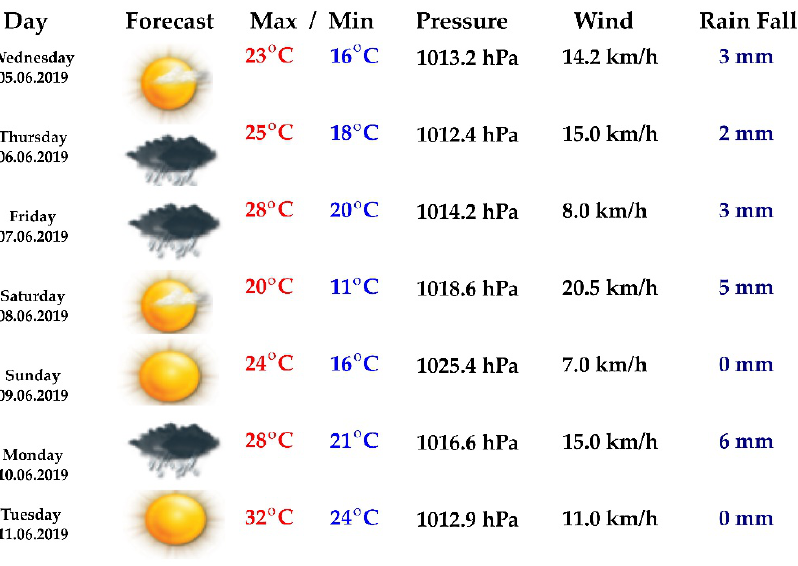
Table 1. Basic parameters of the supply voltage according to EN